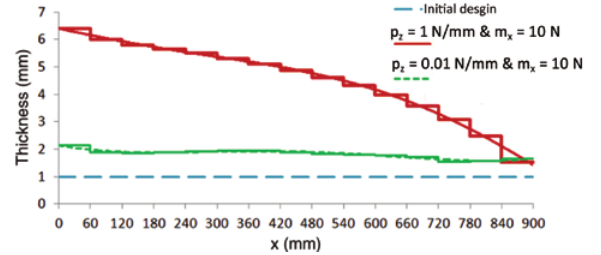
Figure 14: Optimization of clamped-free flat plate problem (Figure 10) subject to distributed lateral force p moment, m for constrained tip displacement d x